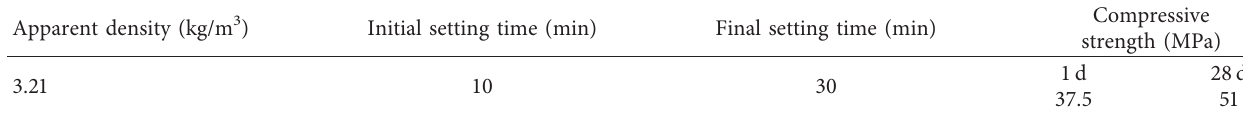
Table 4: Physical performance of LASC.